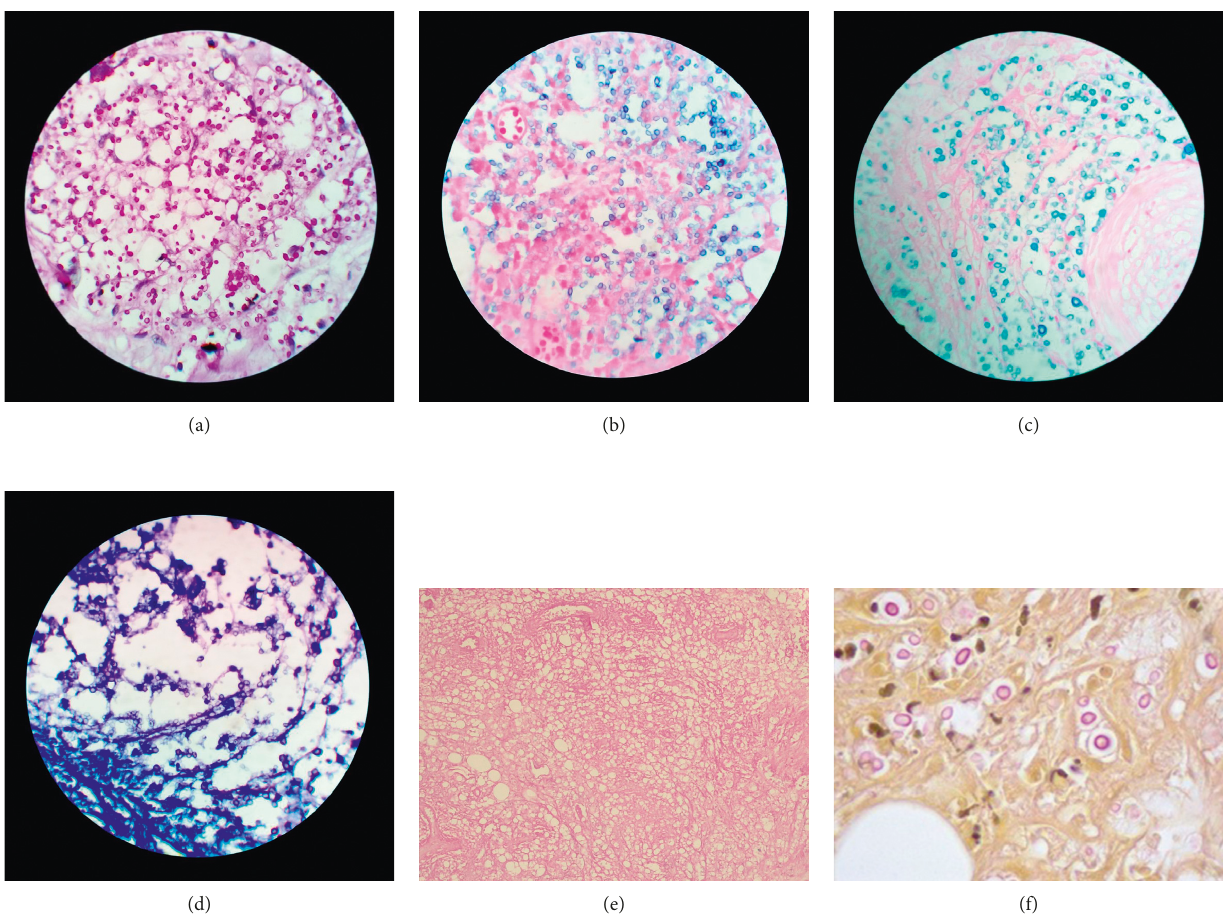
Figure 3: (a) Periodic acid-Schiff (PAS), (b) alcian blue, and (c) colloidal iron stains were positive, but (d) Giemsa and (e) Prussian blue stains were negative for cryptococcus. (f) Mucicarmine stain was positive for